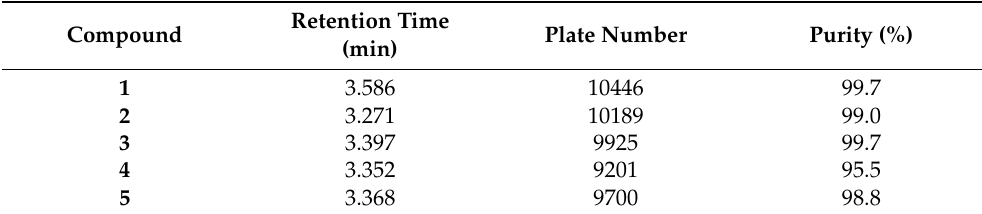
Figure 2. The purity of synthetic 1-methylhydantoin cinnamic imides was determined using HPLC- UV chromatogram at 254 nm. Table 1. Purity data of 1-methylhydantoin cinnamic imides based on the Liquid Chromatographic Peak Area